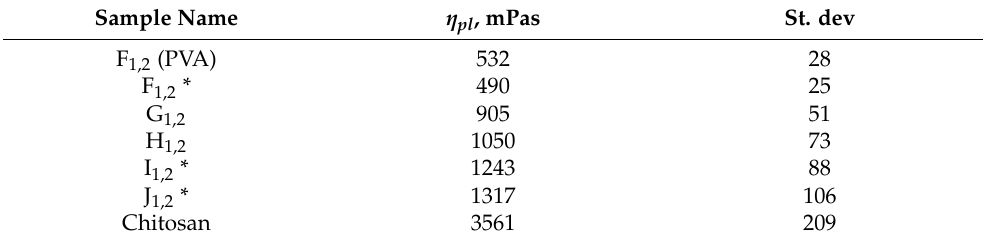
Table 2. Calculated viscosity ( η pl , mPas) values from flow curves. All η pl values increased signifi- cantly compared to the PVA ( p < 0.05), and all data increased significantly compared to one another ( p < 0.1), * after the samples name except for I and